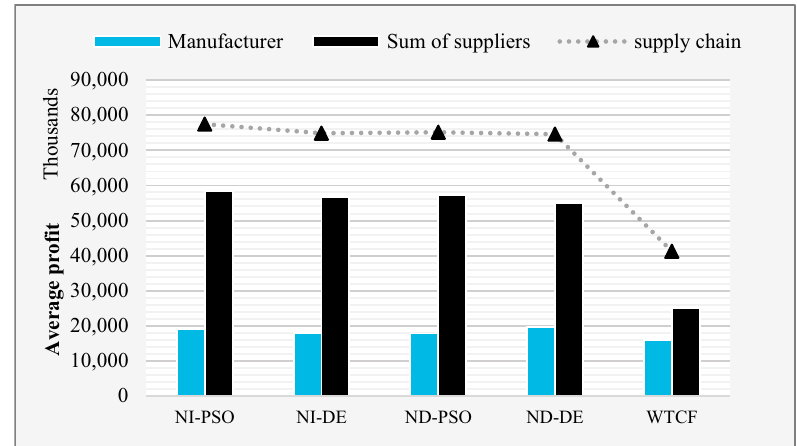
Fig. 6 A comparison between the performance of the proposed solution algorithms in problem size 1